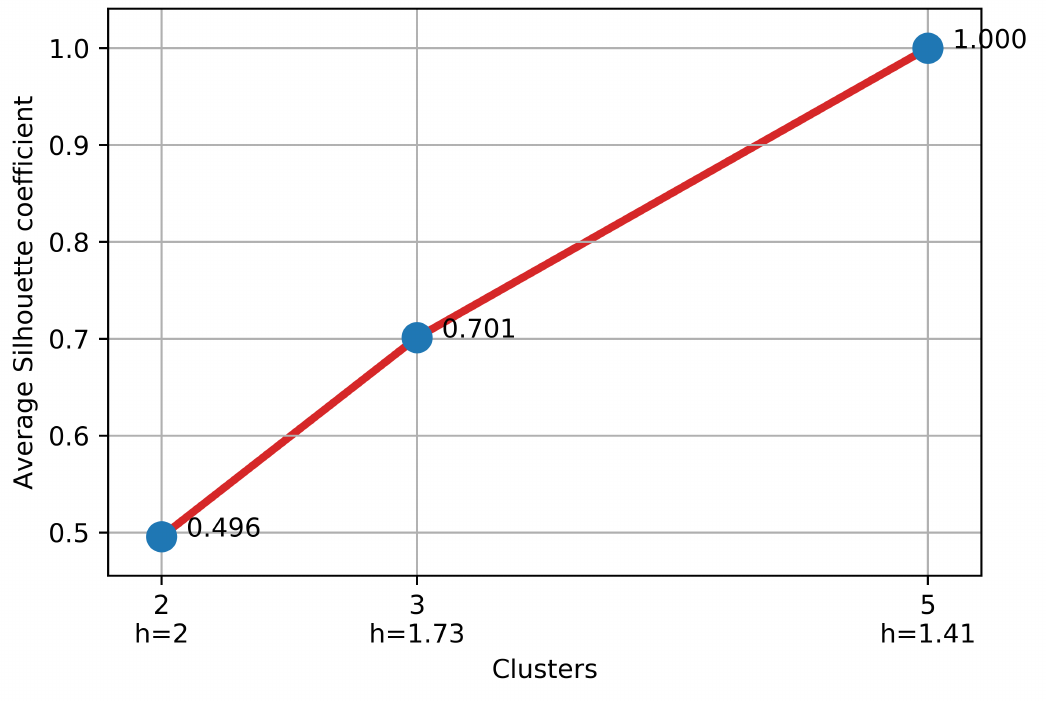
Figure 5. Average silhouette coefficient by clusters